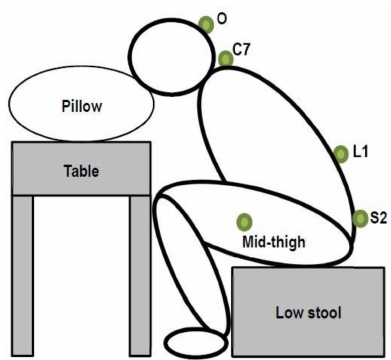
Figure 2. Simulated deep squatting position. Notes: O = occiput, C7 = spinous process of C7 vertebra, L1 = spinous process of L1 vertebra, S2 = spinous process of S2